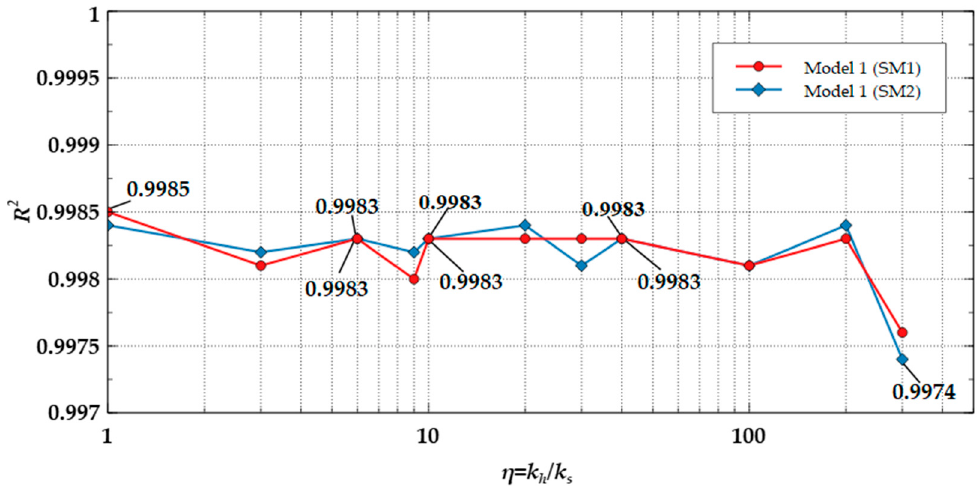
Figure 7. R 2 for Model 1 with different locations.